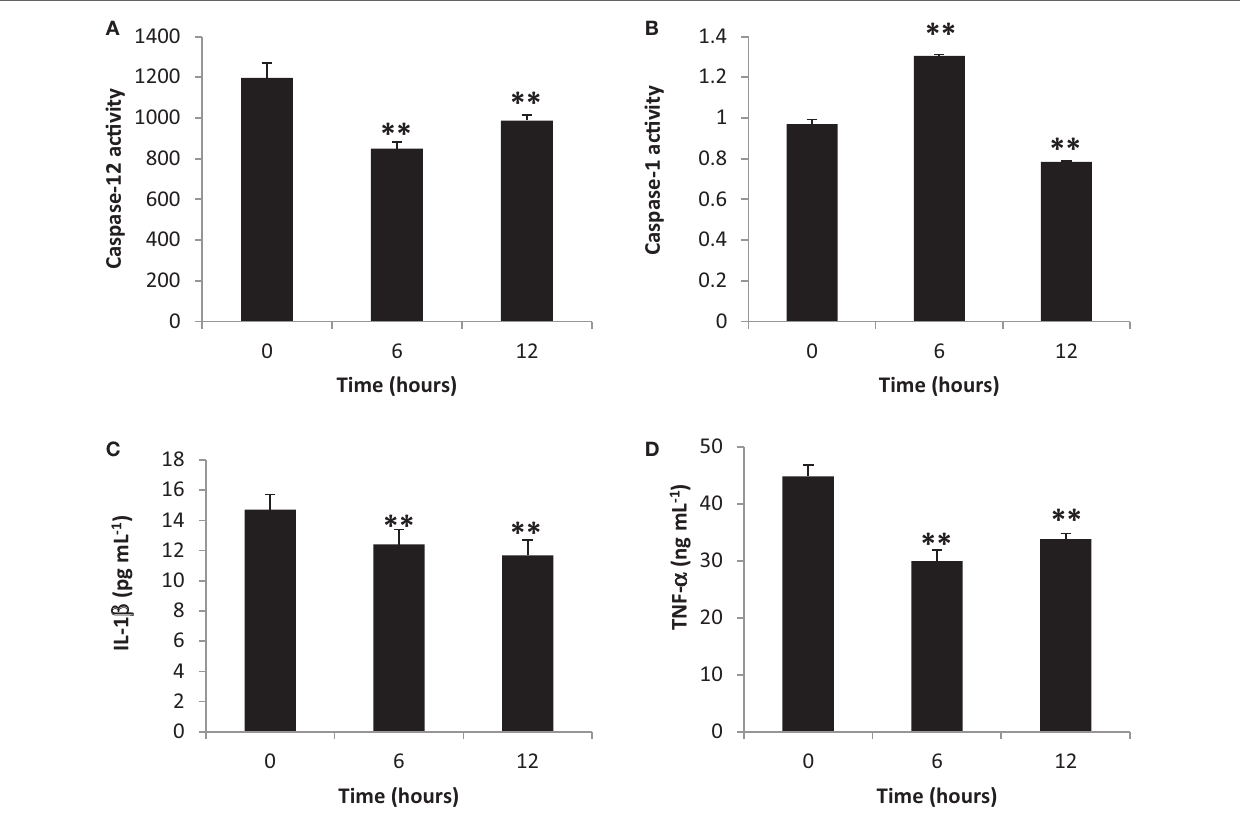
FigUre 2 | Inflammatory caspase and cytokine activities in the blood cytosol are decreased ascribable to gingival periodontal disease level-butyric acid (BA). Quantification of blood cytosolic (a) caspase-12 activity, (B) caspase-1 activity, (c) IL-1 β amounts, and (D) TNF- α amounts are indicated. Results shown are mean ± SE utilizing independent blood samples (collected at 0, 6, and 12 h post-treatment with BA) of 10-week-old Wistar male rats ( n = 6). Statistical analyses were performed using Anderson–Darling normality test and, if passed ( p > 0.05), Student’s t -test (** p <